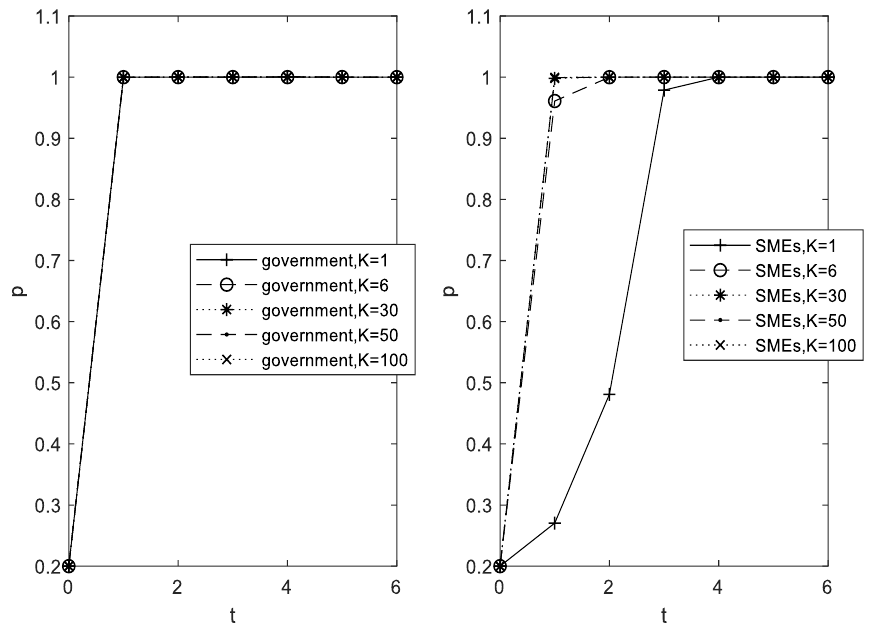
Figure 5. The effect of government regulatory agencies’ punishment on the negative performance of CSR K on the results of system evolution.